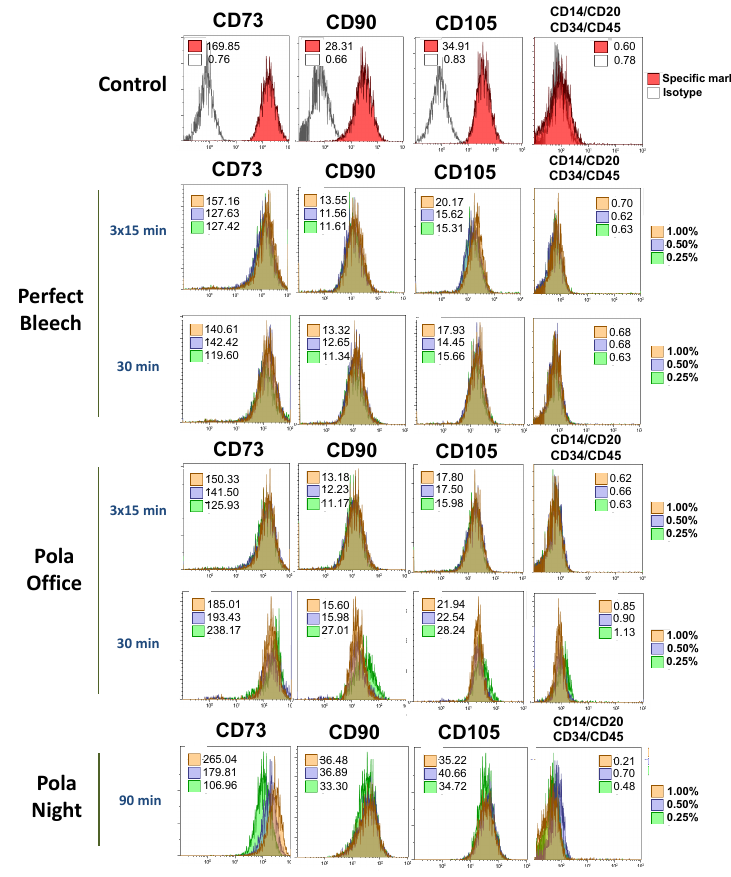
Figure 6. Mesenchymal phenotype analysis of h DPSCs after culture with bleaching products using flow cytometry. Cells were cultured for 72 h, detached and labelled with fluorescence-conjugated specific antibodies for the mesenchymal surface markers CD73, CD90 and CD105 and the hematopoietic markers CD14, CD20, CD34 and CD45. Inset numbers represent the mean fluorescence intensity values of viable cells. Histograms show representative flow cytometry results from three independent